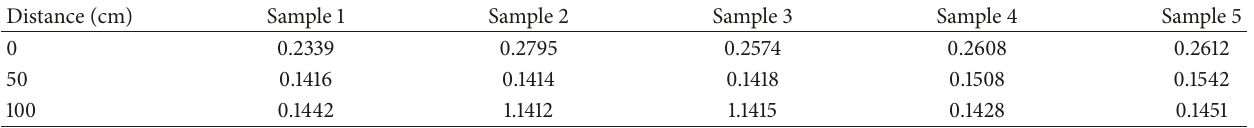
Table 1: 𝛾 -radiation dose rate of uranium tailings; unit: 𝜇